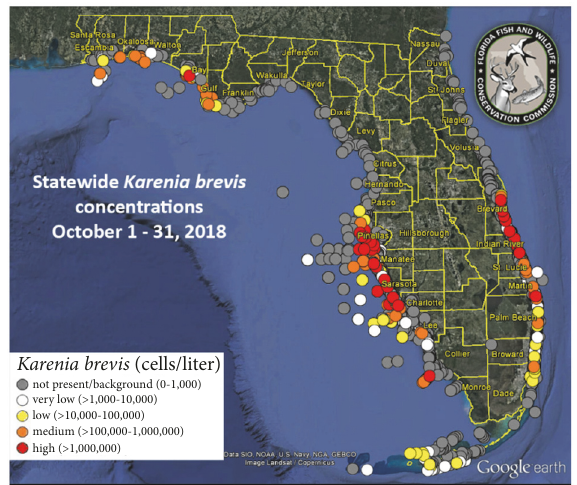
Figure 1: Concentrations of Karenia brevis during exposure. Image source: Florida Fish and Wildlife Conservation Commission.